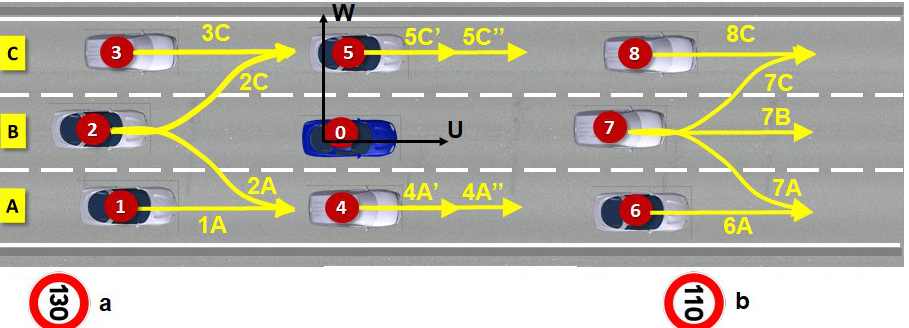
Figure A2. Prediction of possible trajectories for objects 1 to 8 depending on their position relatively to the ego-vehicle and traffic rules.